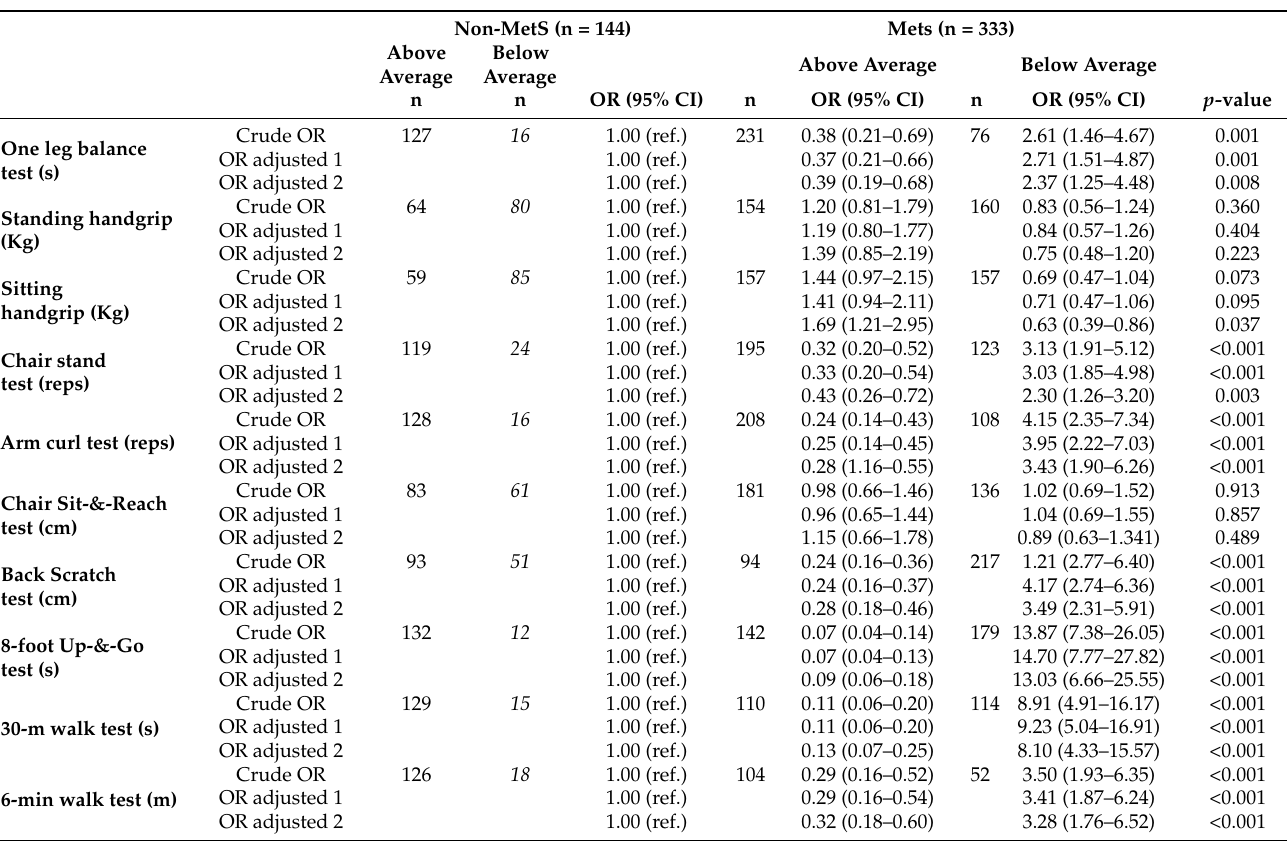
Table 3. Logistic regression models for age and sex specific cut-off values * of functional fitness tests (dependent variables) in MetS and non-MetS participants (independent variables).